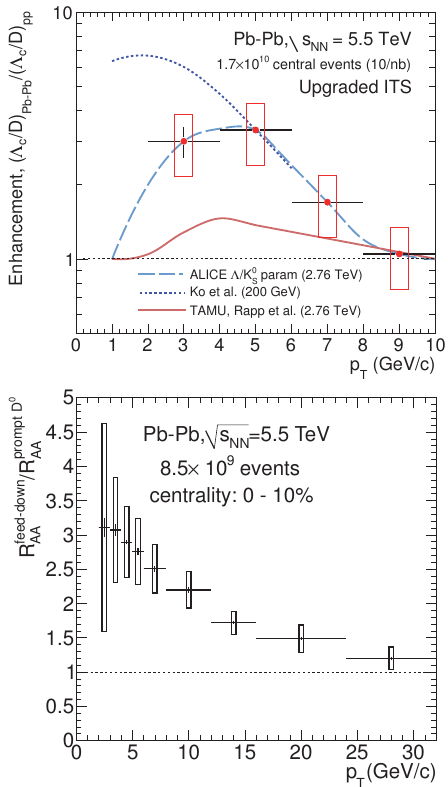
Figure 6. Top: Enhancement of the Λ c / D 0 ratio in central Pb- Pb collisions with respect to pp collisions, compared with model calculations[7, 8]. Bottom: Expected measurement of the ratio of D meson yields with feed-down from B and prompt D, to be measured with the upgraded